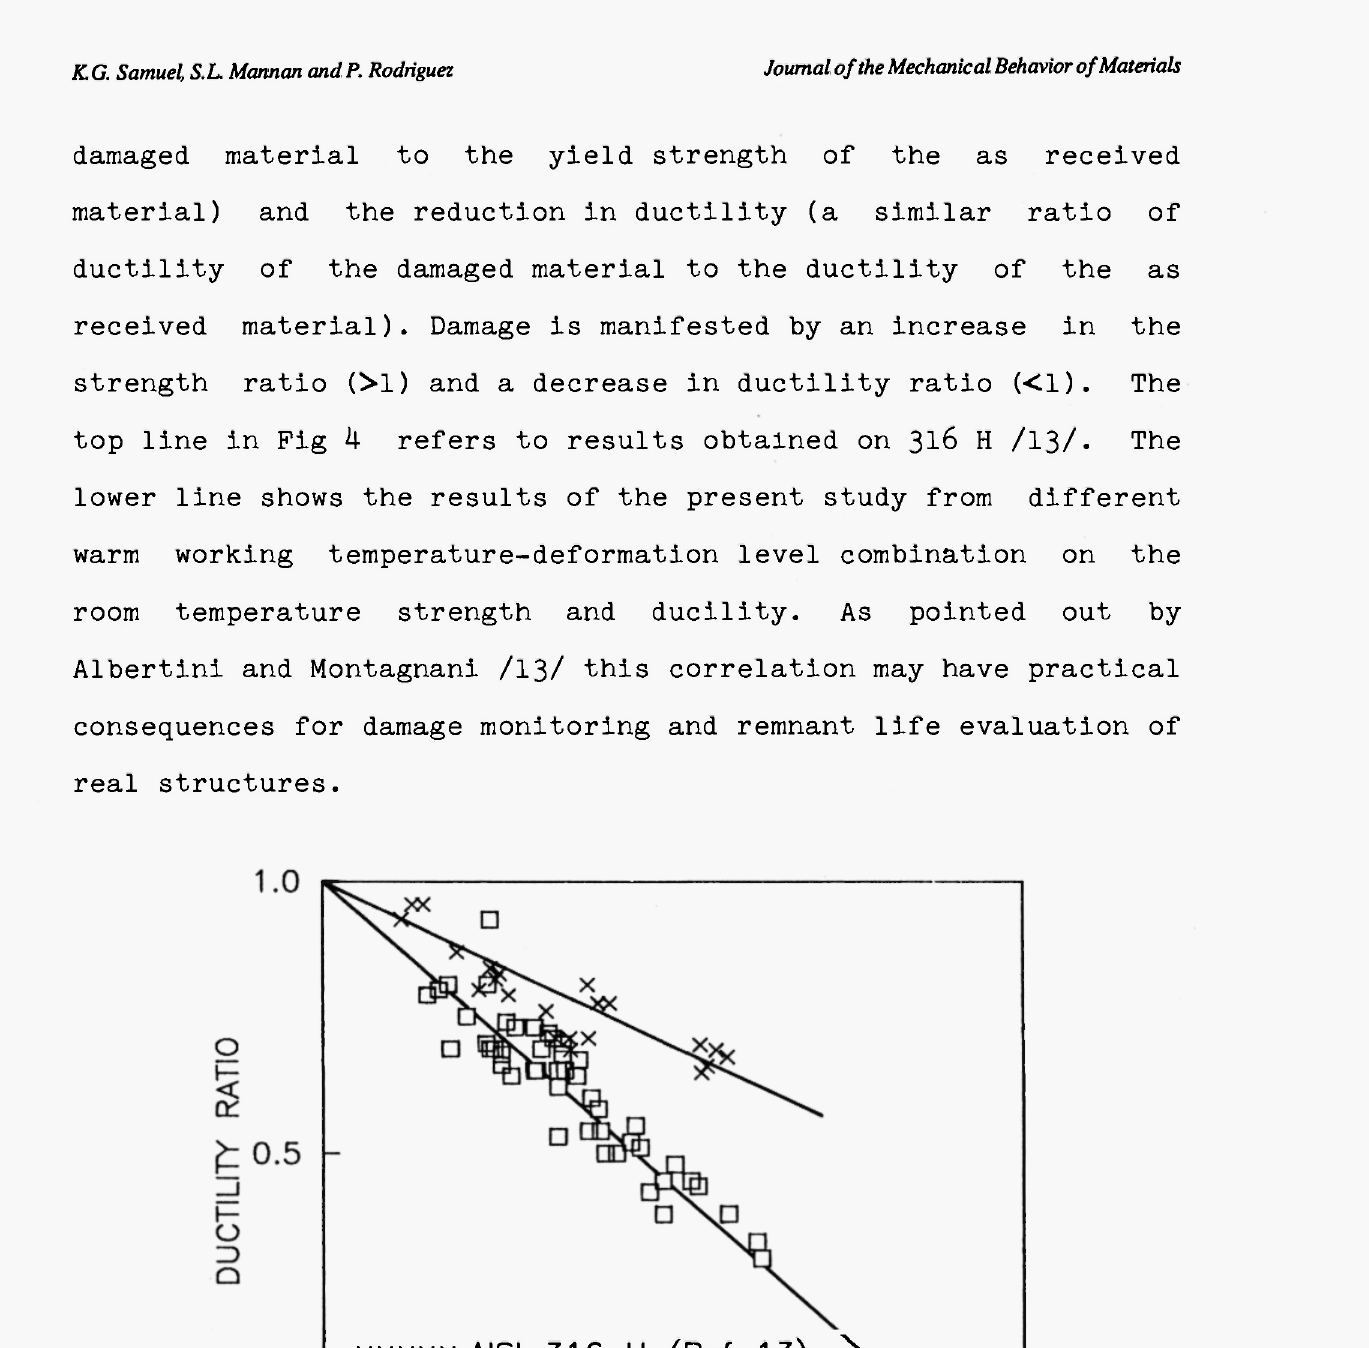
Fig.4. Variation of the ductility ratio with the yield strength